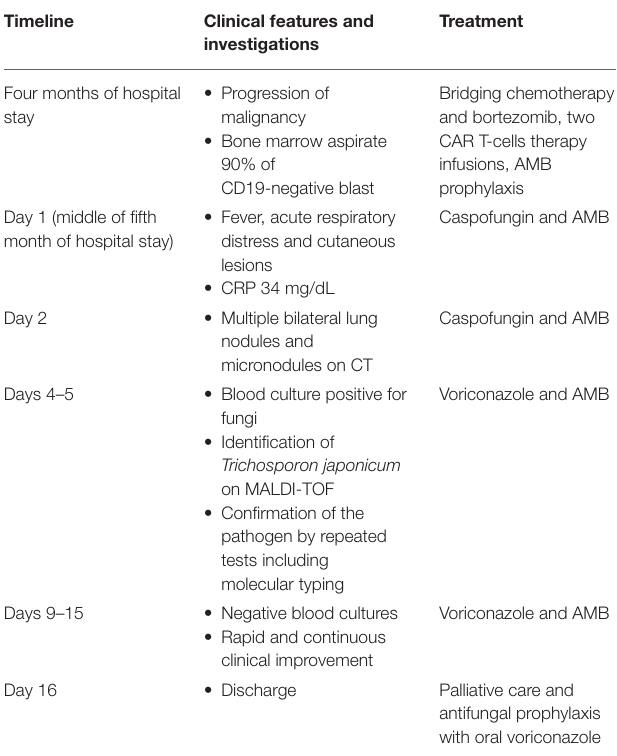
TABLE 1 | Timeline of Trichosporon japonicum fungemia